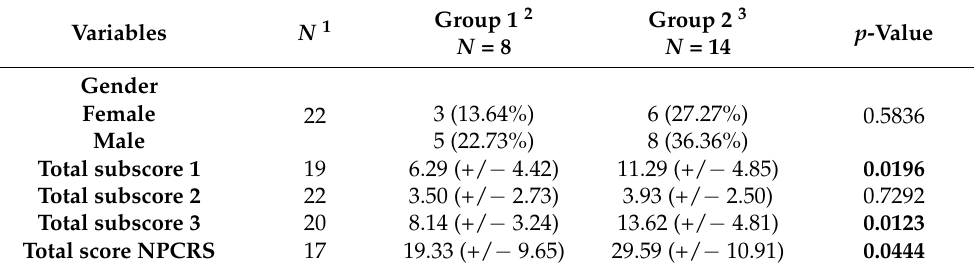
Table 3. Subscores and total Nijmegen score in patients with nucleotide change involving folding or stabilization together with one non-functioning allele and patients with one non-functioning allele combined with another allele.